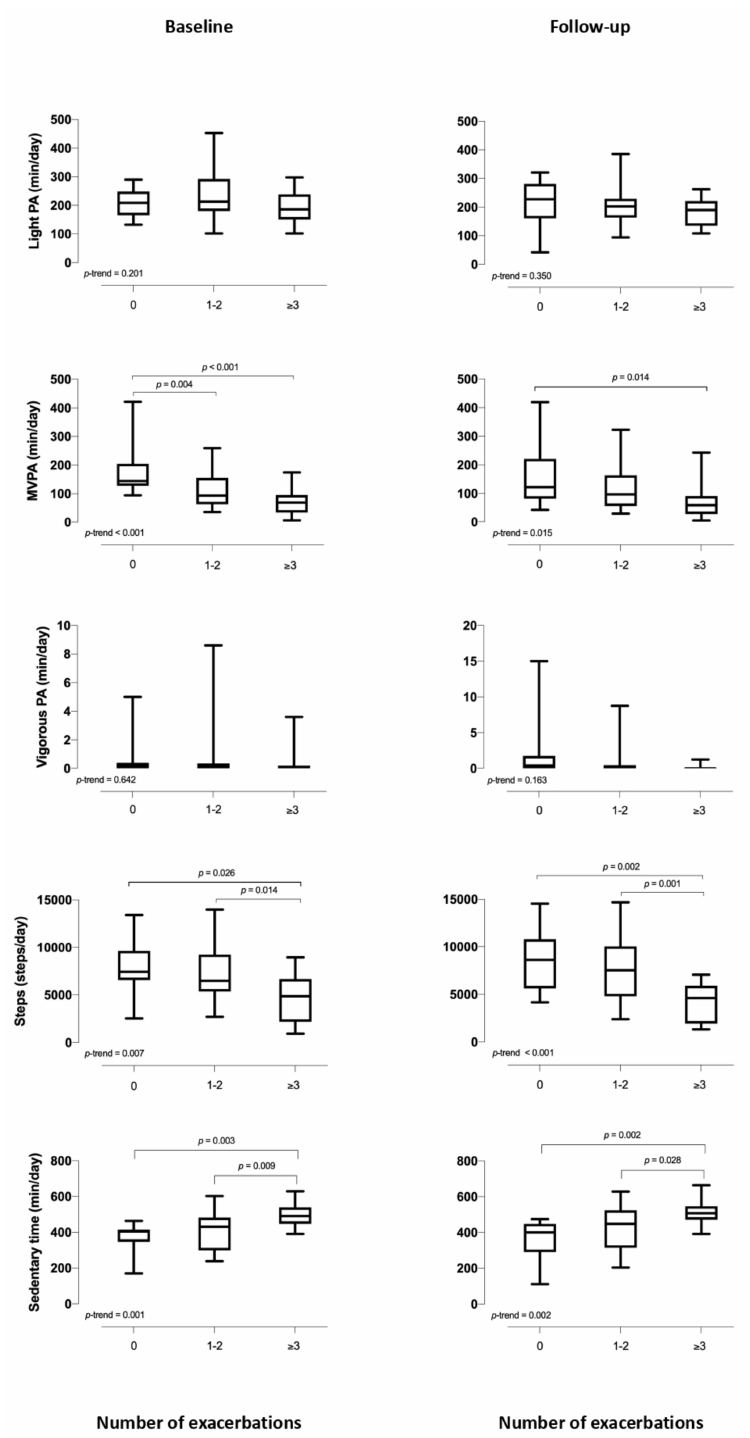
Figure 2. Physical activity and sedentary behaviour at baseline and follow-up according to number of exacerbations. The box and whisker plots show the mean ± SD for each physical activity variable and sedentary time by the number of exacerbations (0, 1–2, and ≥ 3). The left and right figures show the data for baseline and one year, respectively. Abbreviations: min, minutes; MVPA, moderate-to- vigorous physical activity; PA, physical